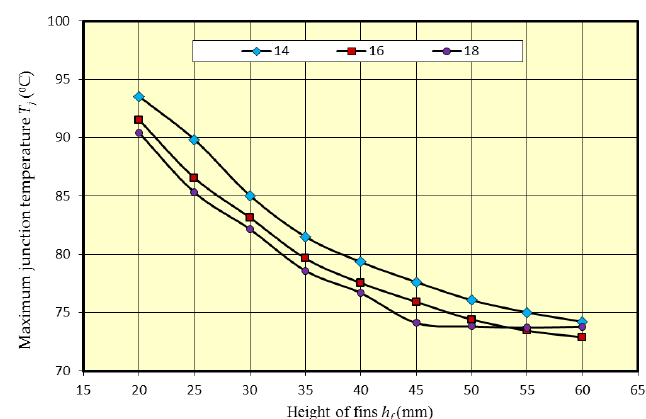
Figure 13. Maximum junction temperature T j of the installed LED panel sources in the function of fin height.